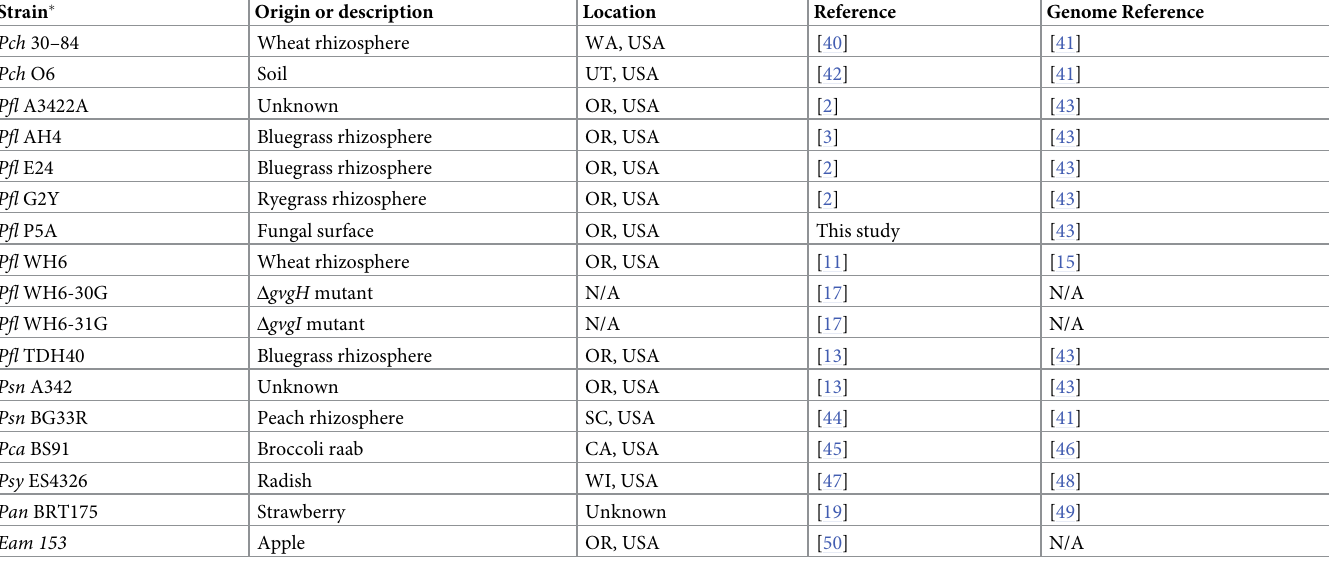
Table 1. Strains used in this